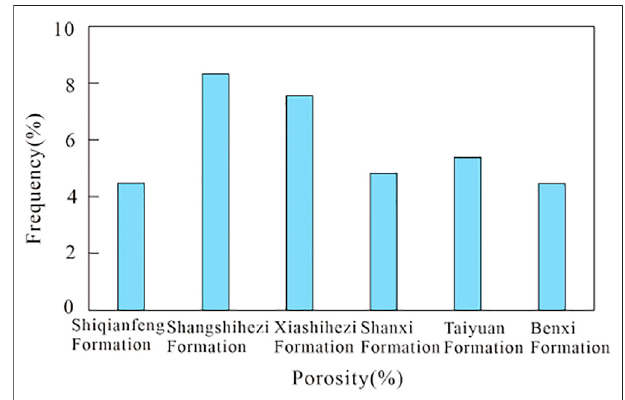
FIGURE 3 | Histograms of the porosity levels of the Upper Paleozoic reservoirs within the Dongpu